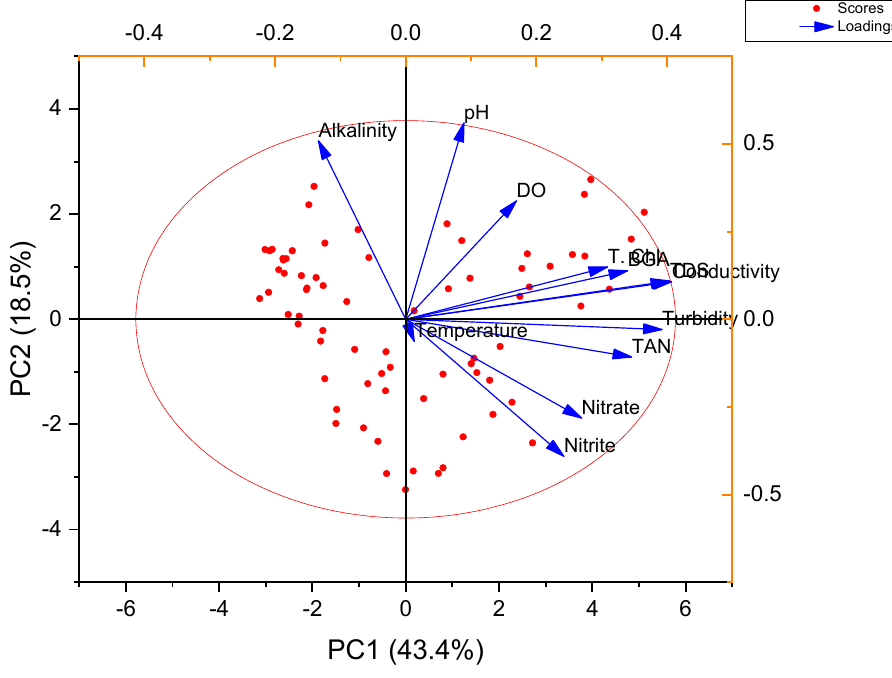
Figure 2. Principal Component Analysis (PCA) biplot of water quality variables observed during the experimental period. Blue arrows indicate the direction of increasing values for each variable. ( n = 72).